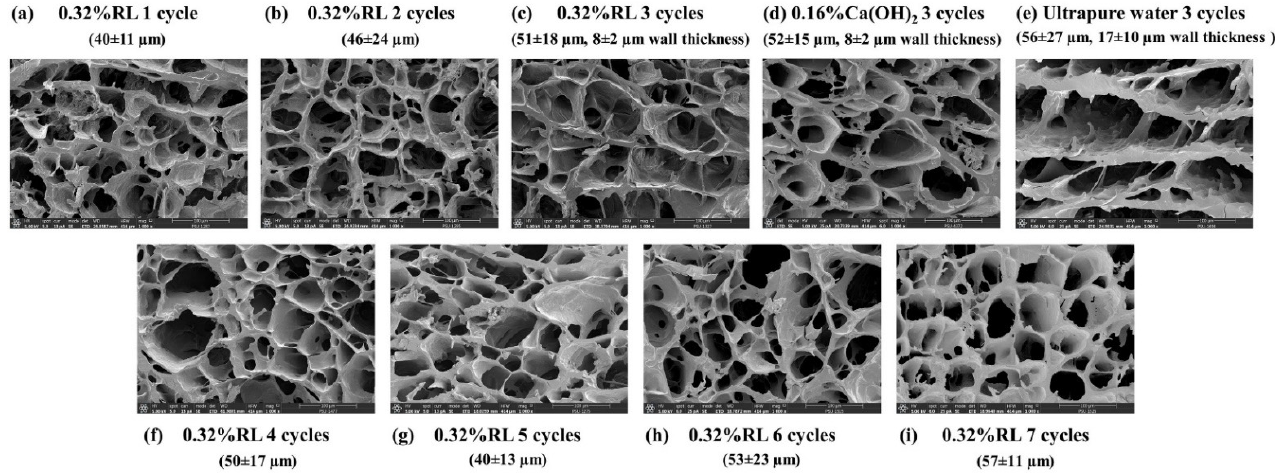
Figure 3. FE-SEM images and average pore sizes of the cryogels prepared by using ( a – c , f – i ) 0.32% RL with 1–7 freeze–thaw cycles, respectively ( d ) 0.16% Ca(OH) 2 , and ( e ) ultrapure water with three freeze–thaw cycles under the optimal conditions.